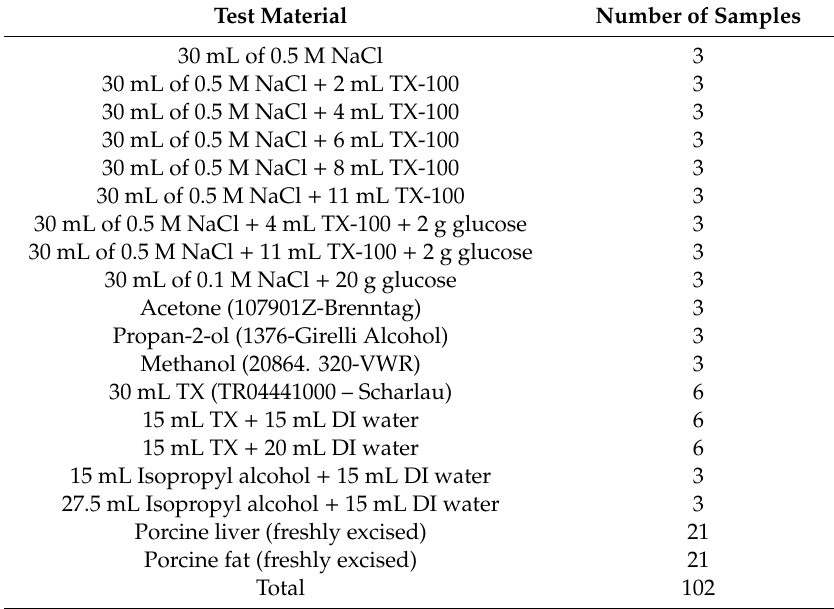
Table 1. Test materials and respective number of samples. To the authors’ knowledge, there is no published information on the highlighted